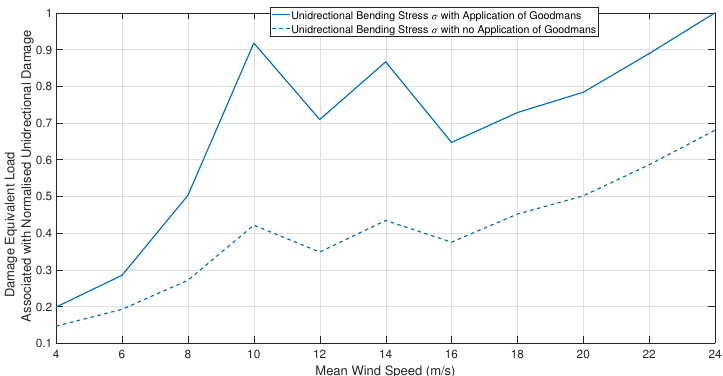
Figure 19. Comparison of normalised damage equivalent load associated with uni-directional fatigue damage using 10 min bending stress σ time series with and without Goodman’s correction where θ and τ are fixed at 0 ◦ .